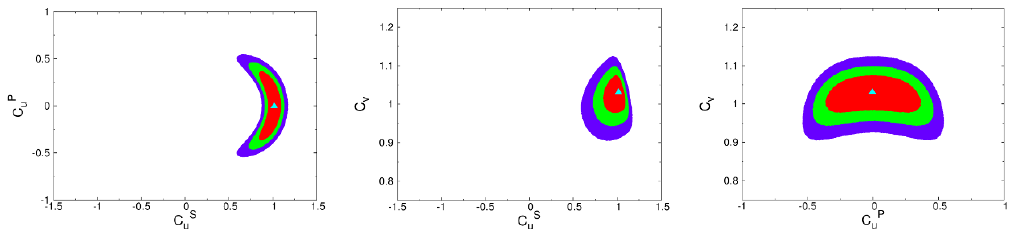
, C P , and C v . The color u u